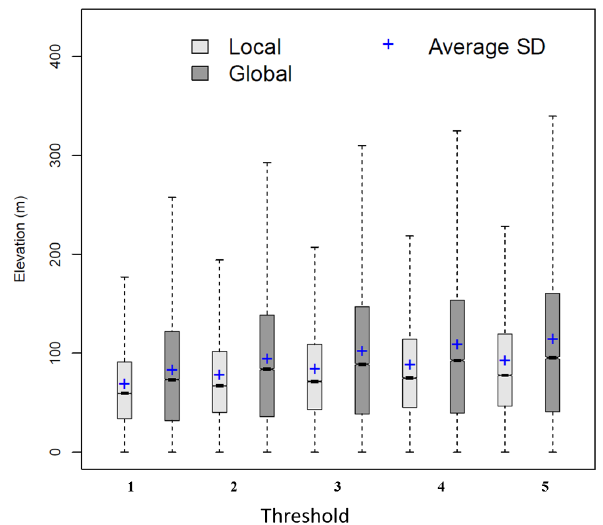
Figure 10. Similar to Fig. 6, but for the capability of the global and local methods to capture topographic heterogeneity based on the standard deviation in elevation, within the non-geo-located SUs derived based on elevation, slope and aspect using different values of area threshold.